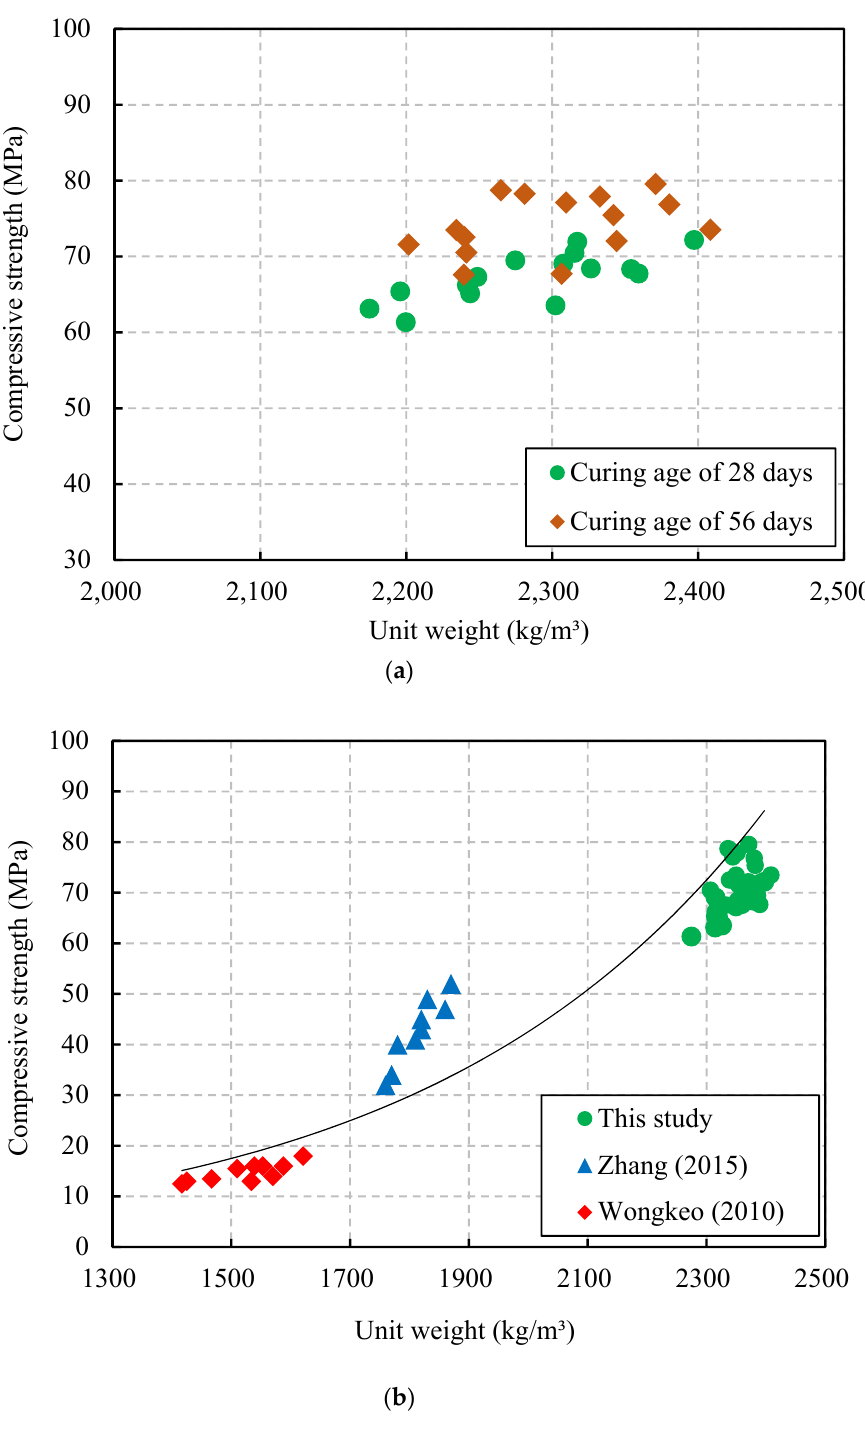
Figure 10. Relationship between the compressive strength and the unit weight. ( a ) Test results in this study; ( b ) relationship based on the results in this study and previous studies.